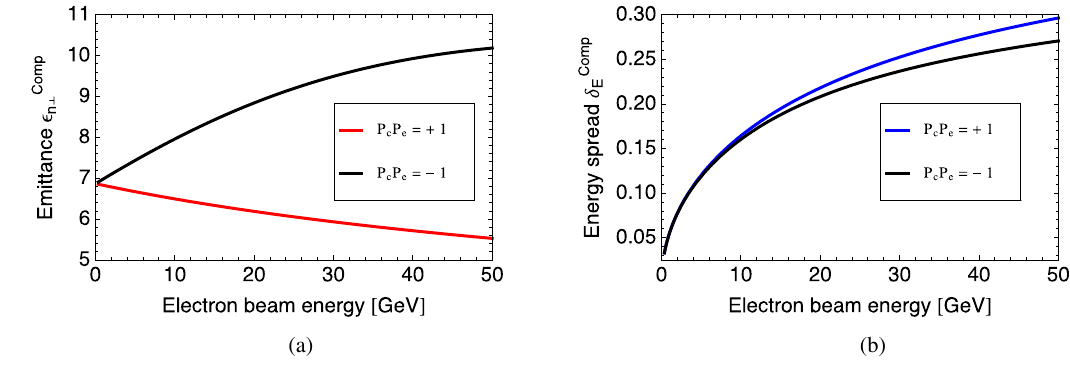
FIG. 3. Compton dynamics including the polarization of the initial states. (a) and (b) show, respectively, the deviations in the equilibrium normalized transverse emittance and relative energy spread (see Fig. 2) at different electron beam energies varying the ¼ (cid:2) 1 range. The collision parameters are the same as for Fig. P polarization product in the P c e